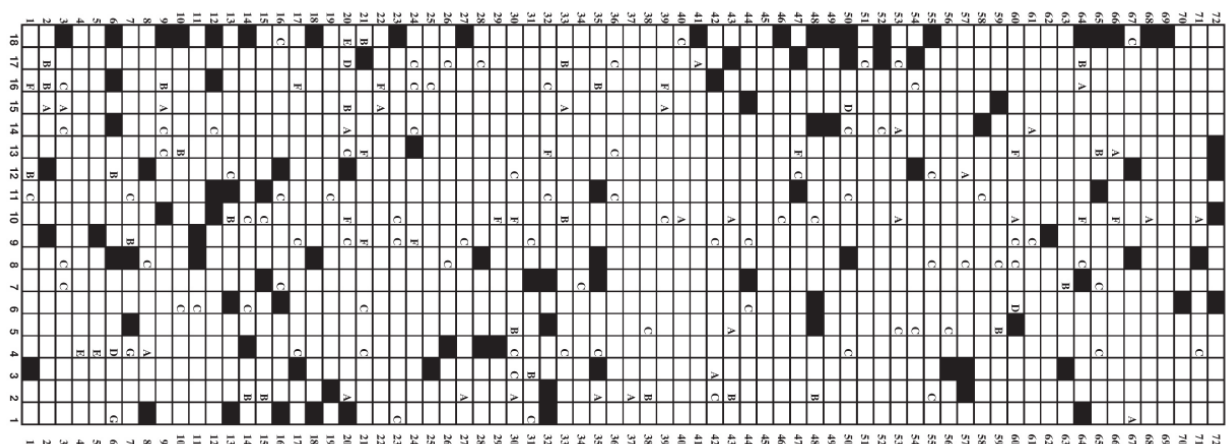
Fig. 1. Annual and cumulated spatial distribution of esca in the study plot. A. symptom expression in 2002; B, symptom expression in 2003; C, symptom expression in 2004; D, symptom expression in 2002 and 2003; E, symptom expression in 2002 and 2004; F, symptom expression in 2003 and 2004; G, symptom expression in all the three years. Black squares stand for missing value, white squares stand for non-symptomatic.